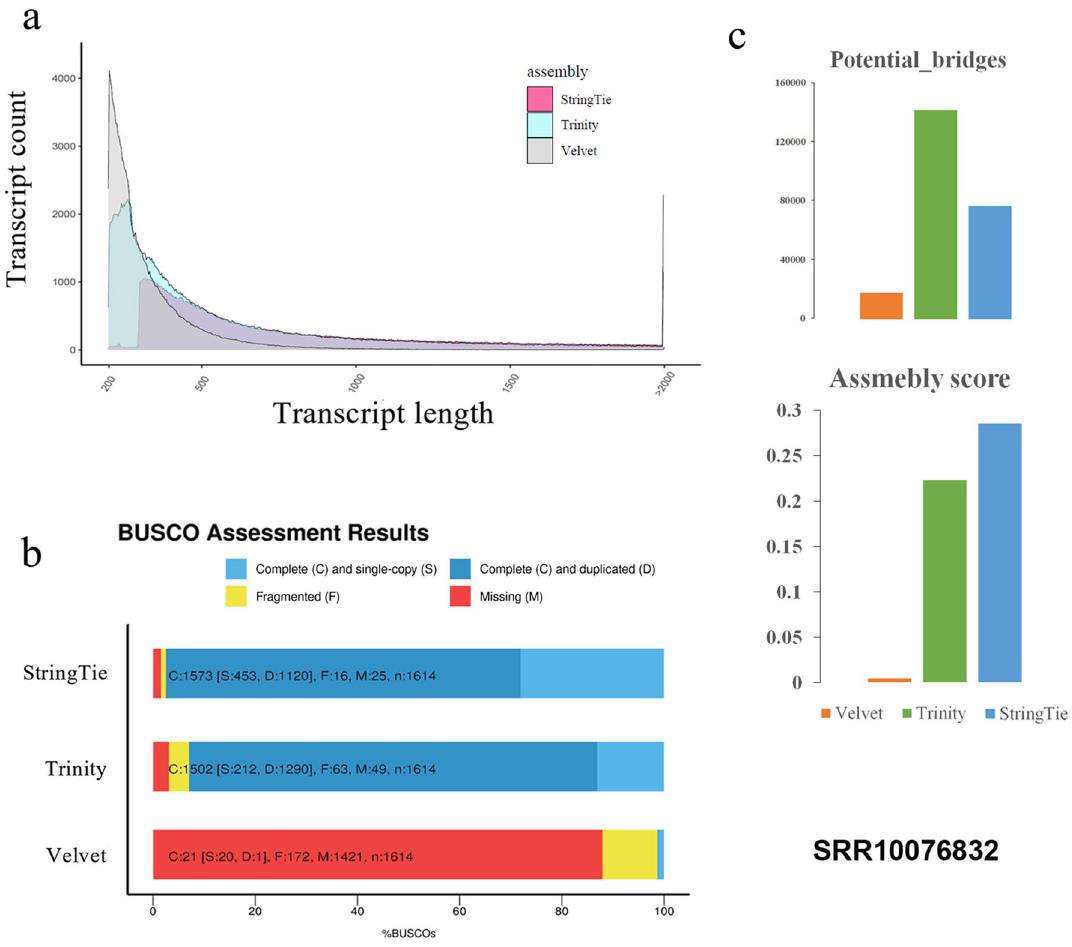
Figure 4. Quality comparison of transcriptomes assembled with the integrative transcriptome-referenced method (using the StringTie assembler) and with de novo assemblers (Trinity and Velvet). An external Illumina sequencing dataset of Bougainvillea × buttiana (SRA: SRR10076832) was involved in the comparison. The quality of transcriptome was evaluated with BUSCO and TransRate. ( a ) The transcript length distribution of transcriptomes assembled by three methods. ( b ) BUSCO evaluation of transcriptomes. ( c ) TransRate evaluation of